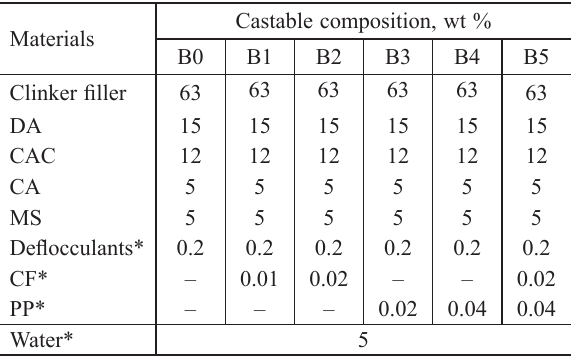
Table 2. Mix proportion of the tested castables